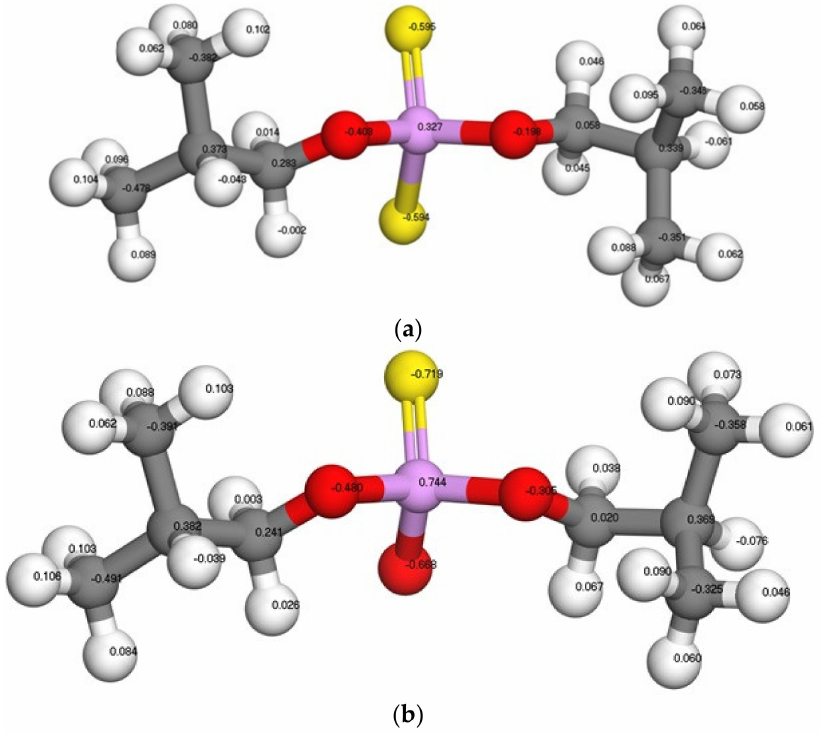
Figure 2. ESP charges of DTP ( a ) and MTP ( b ). White: hydrogen; grey: carbon; red: oxygen; pink: phosphorus; yellow: